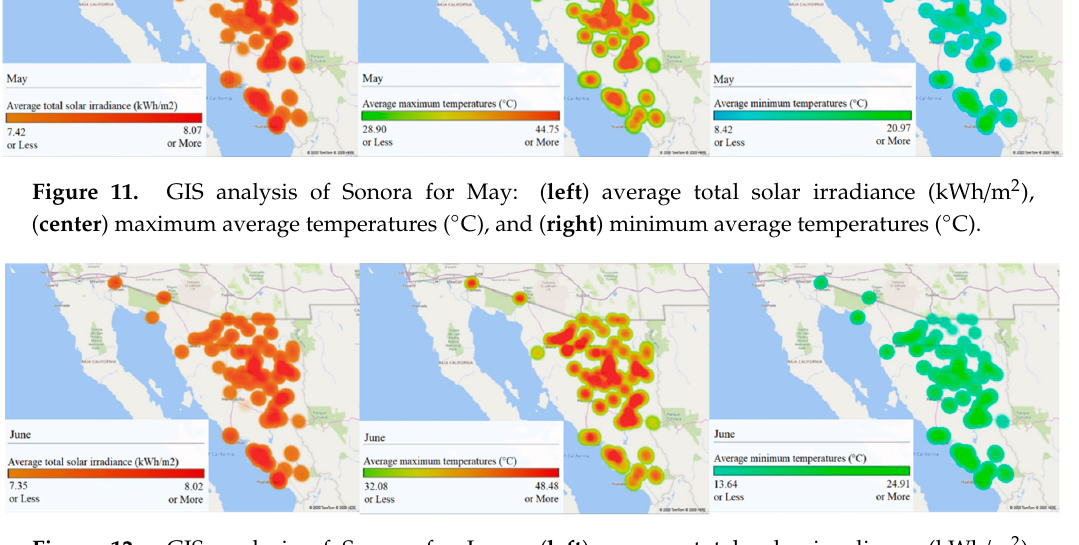
Figure 12. GIS analysis of Sonora for June: ( left ) average total solar irradiance (kWh/m 2 ), ( center ) maximum average temperatures (°C), and ( right ) minimum average temperatures (°C).